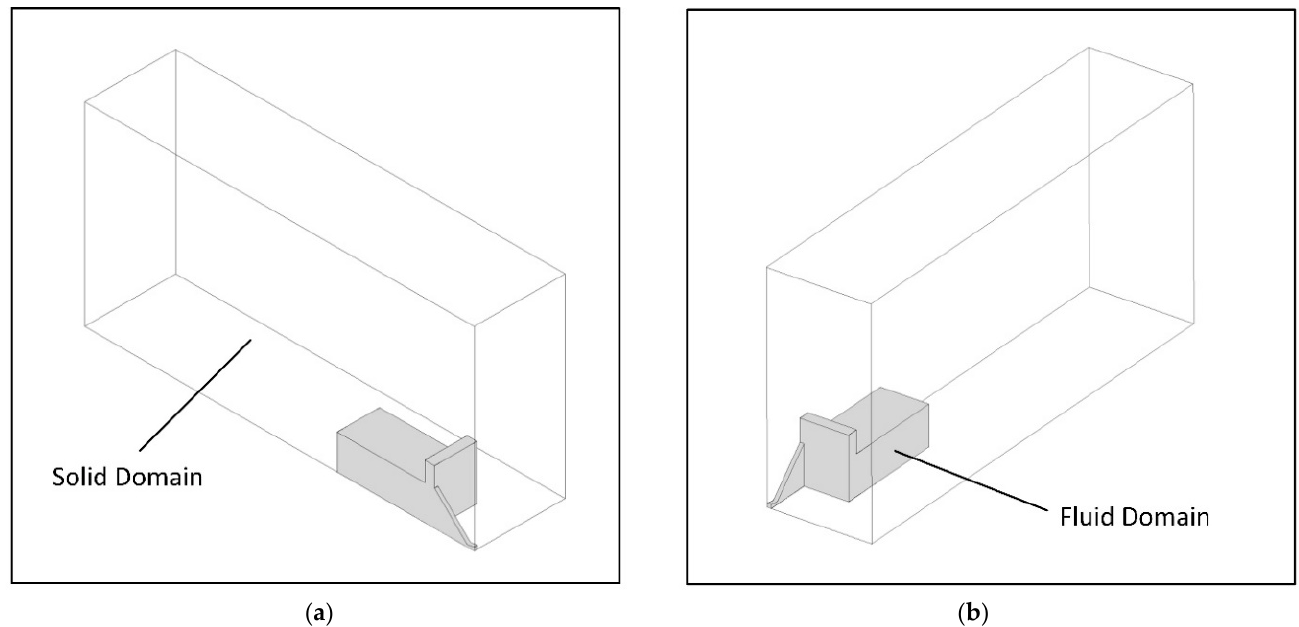
Figure 2. Microthruster computational domain for conjugate heat transfer analysis. ( a ) Left side view. ( b ) Right side view.